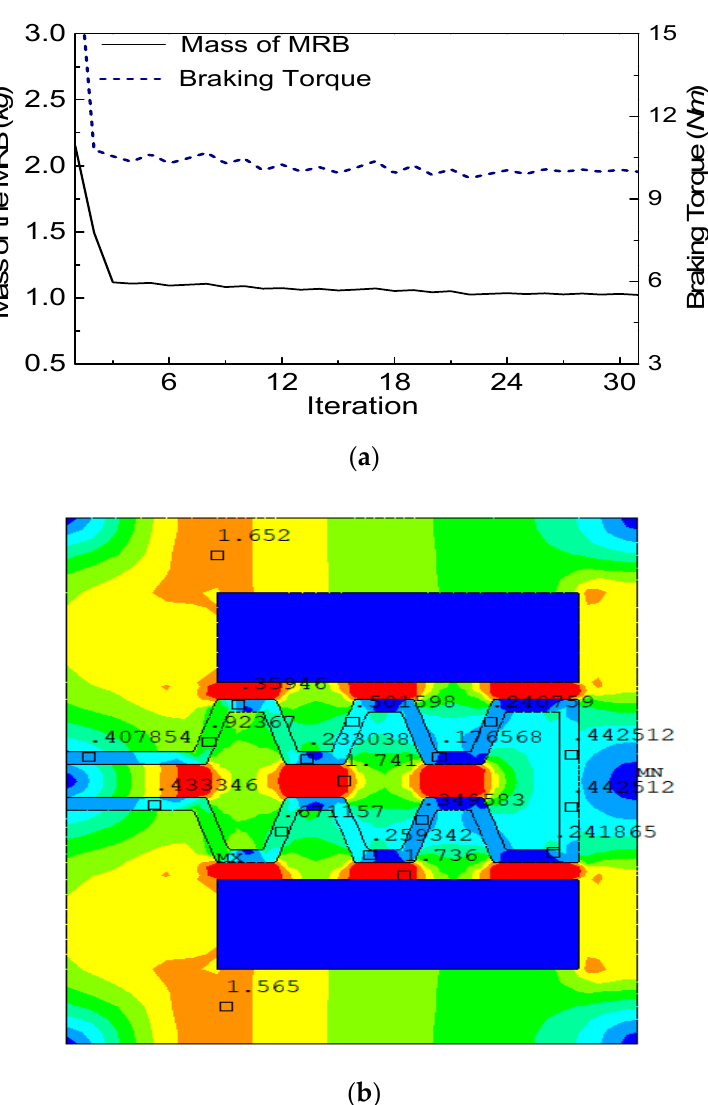
Figure 6. Optimization solution of the rotary MR brakes. ( a ) Mass and braking torque. ( b ) Magnetic flux density of the brake at the optimum.